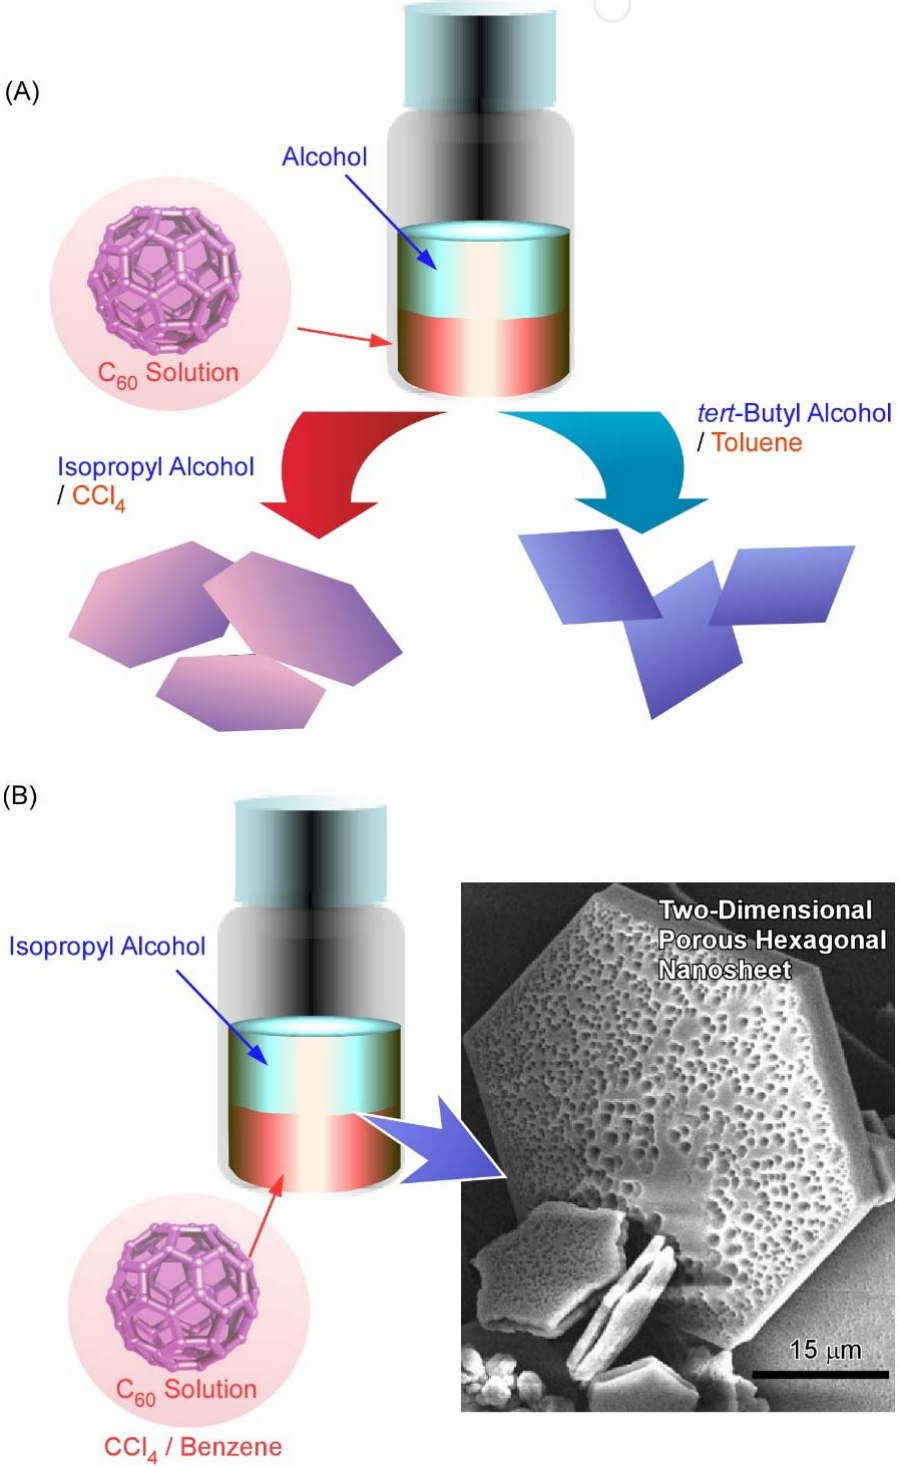
Figure 3. ( A ) Fabrication of variously shaped two ‐ dimensional fullerene assemblies through appropriate choice of solvent combinations for the liquid–liquid interfacial precipitation method. ( B ) Two ‐ dimensional nanosheets possessing dimorphic macroporous/mesoporous structures fabricated via C 60 assembly at interfaces between isopropyl alcohol and CCl 4 /benzene mixtures. Chen and co ‐ workers developed a simple but effective co ‐ solvent induced crystal transformation strategy to transform two ‐ dimensional C 60 microplates to nano ‐ meshes